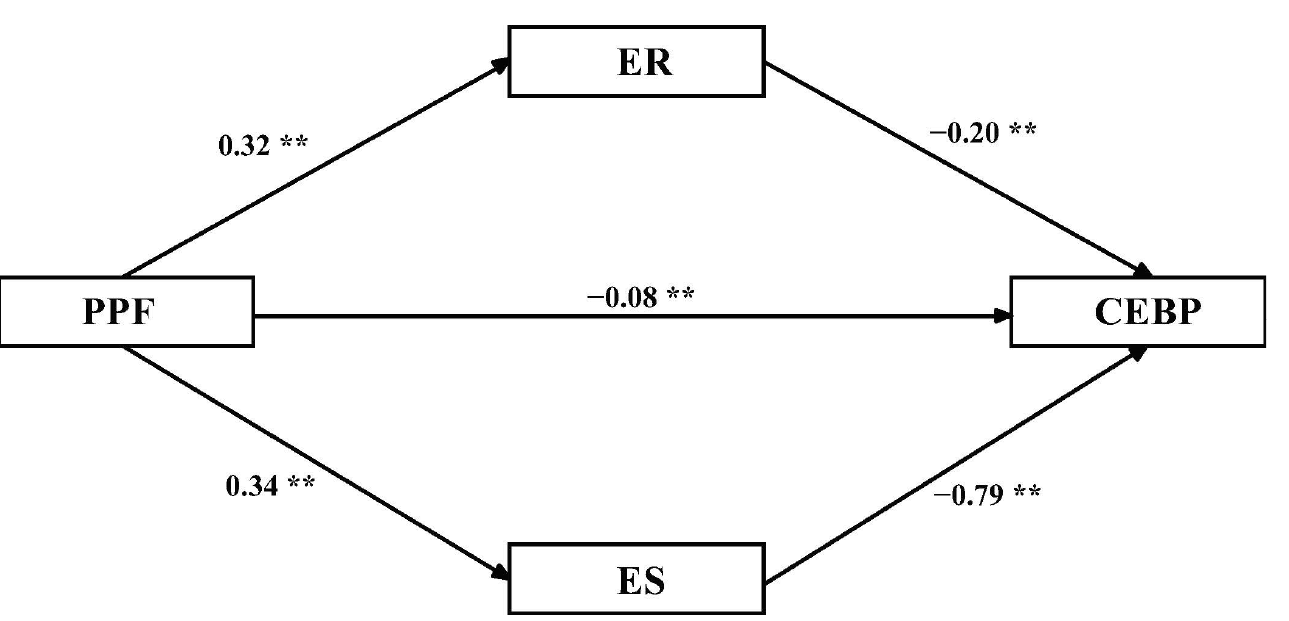
Figure 2. Model diagram of the effect of parental psychological flexibility on externalizing behavior problems. ** p < 0.01; PPF = parental psychological flexibility, ER = emotional regulation, ES = emotional stability, CEBP = children’s externalizing behavior problems.